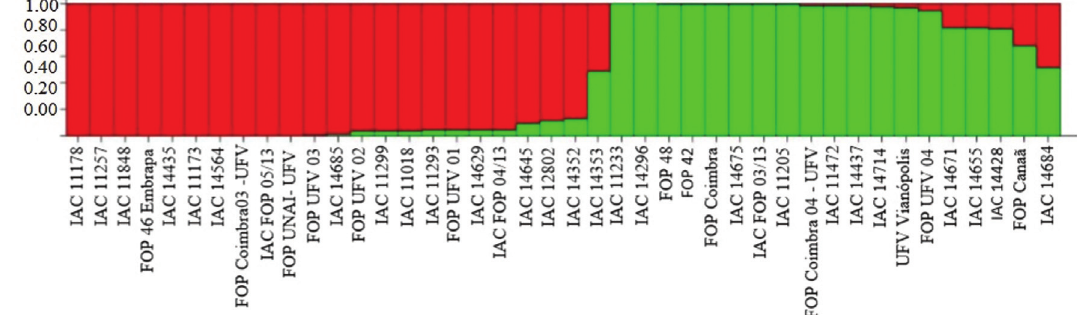
Figure 2 - The genetic structure of the Fop isolates was investigated using the Bayesian clustering algorithm implemented by STRUCTURE v.2.3.4